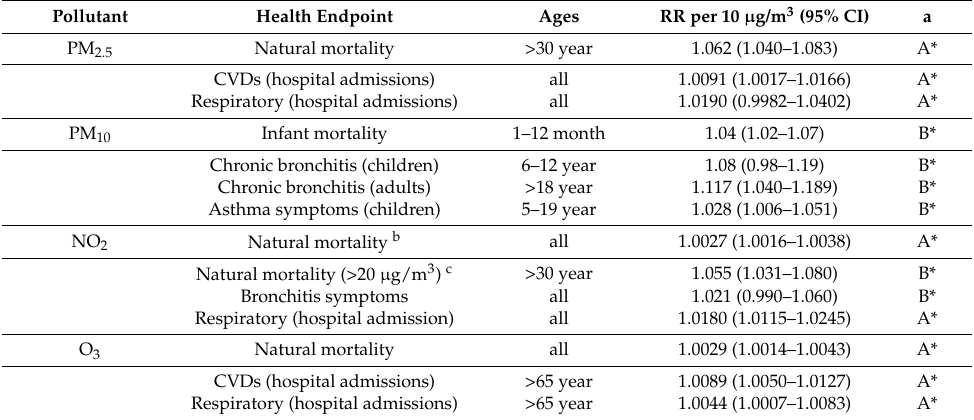
Table 2. Relative risk (RR) estimates with confidence intervals used in this work